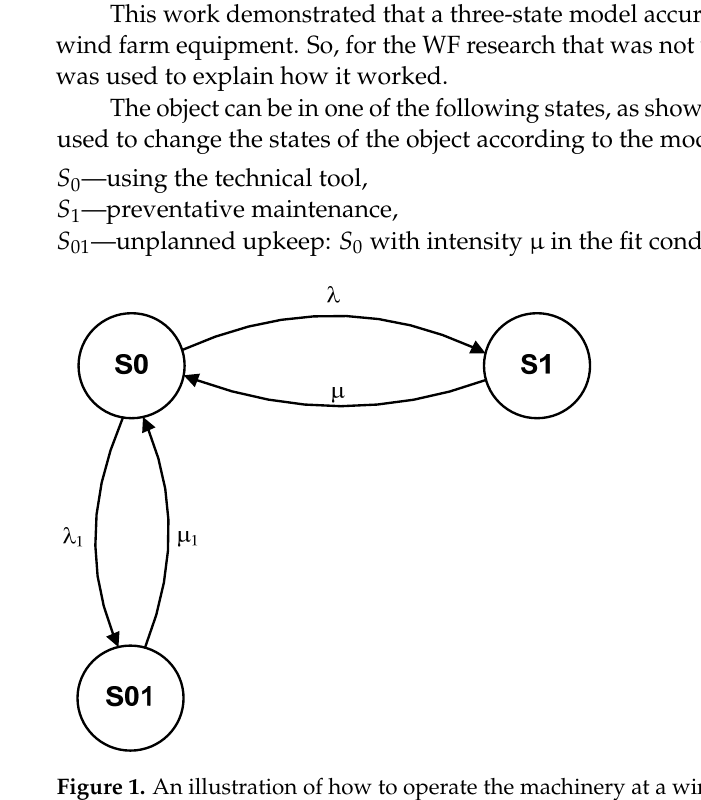
Figure 1. An illustration of how to operate the machinery at a wind farm.